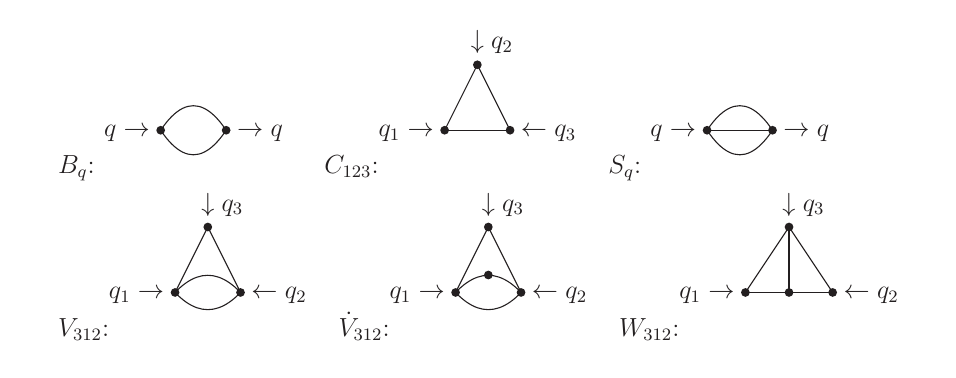
Figure 4. Master integrals entering into the two-loop calculation after applying scalar reduction.